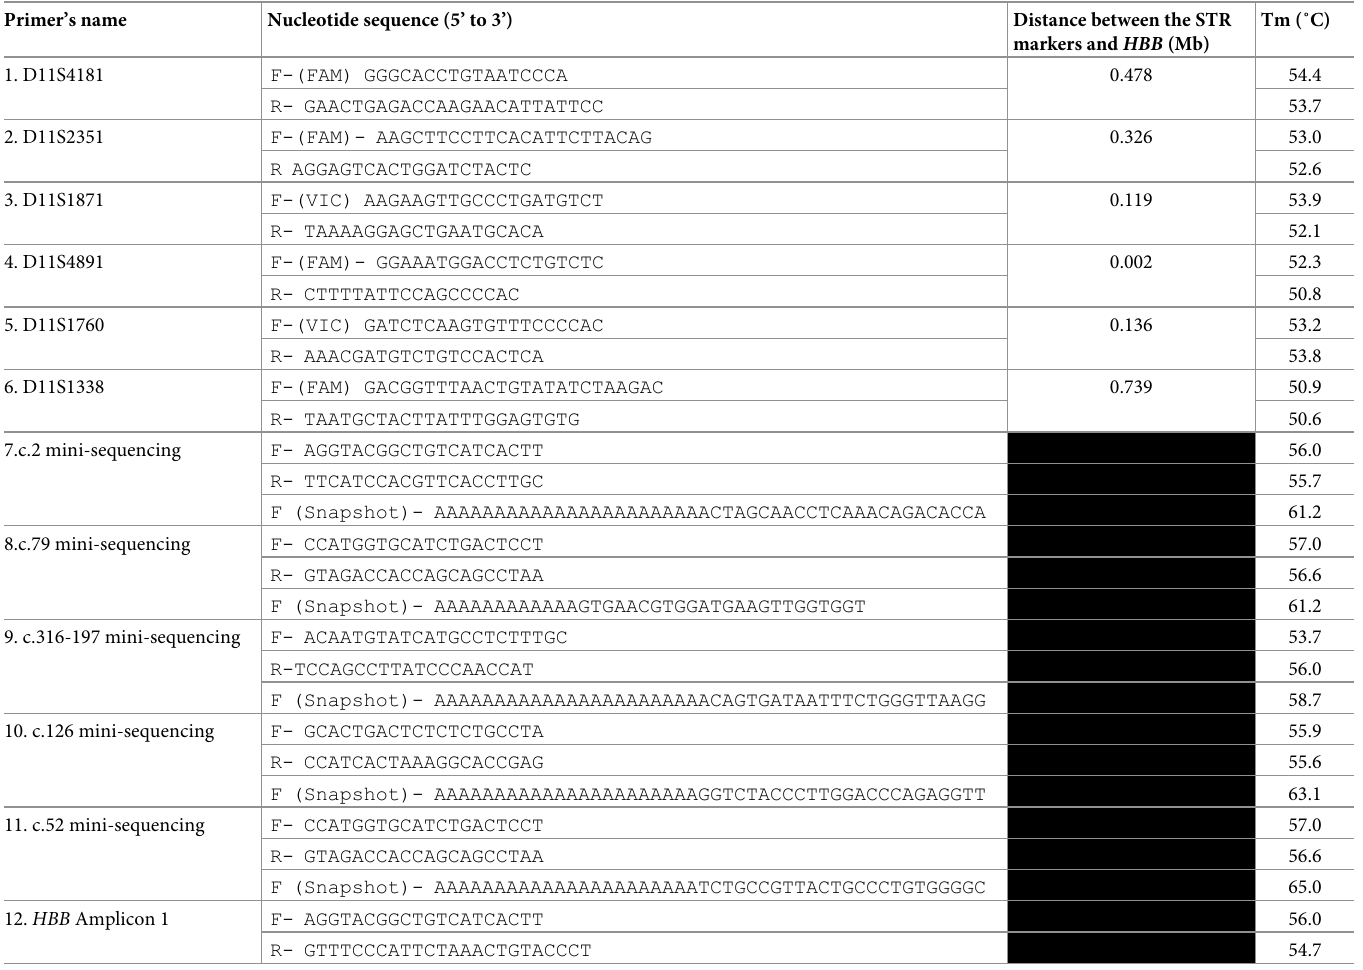
Table 1. Summary of primers using in preimplantation genetic testing for beta thalassemia/hemoglobin E disease. Primer’s